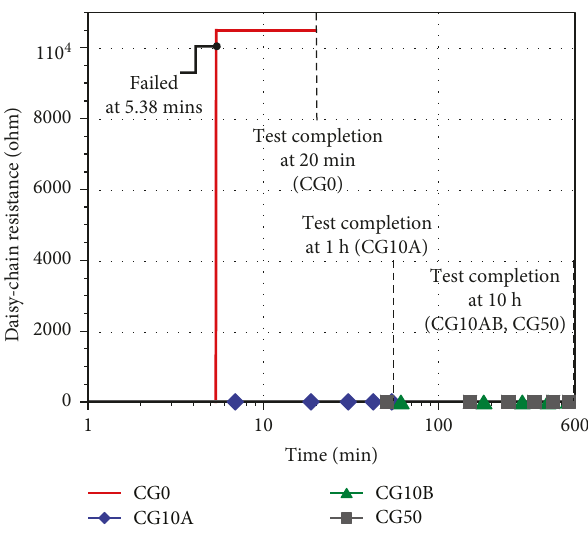
Figure 8: Time pro fi les of daisy-chain resistances for each